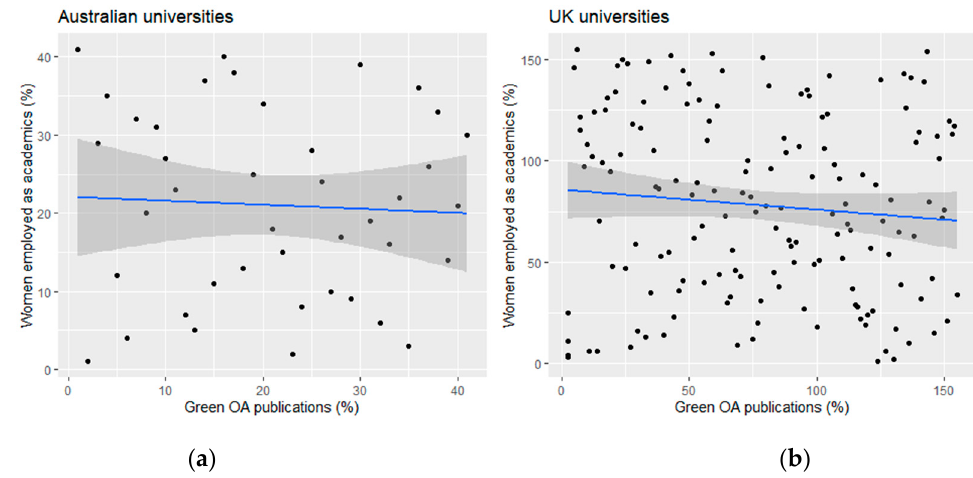
Figure 2. Scatterplot shows correlations between ranks in percentages of women in academic roles and percentages of Green (repository) OA output across ( a ) Australian and ( b ) United Kingdom